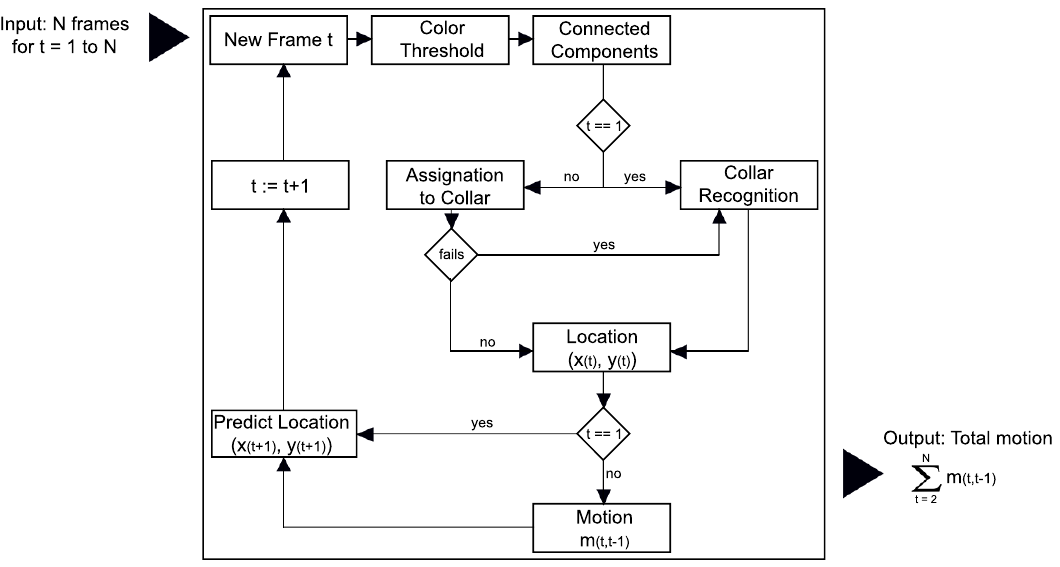
Figure 5. Main workflow of the algorithm. Step-wise processing of all video frames including Object Recognition, Object tracking and Motion